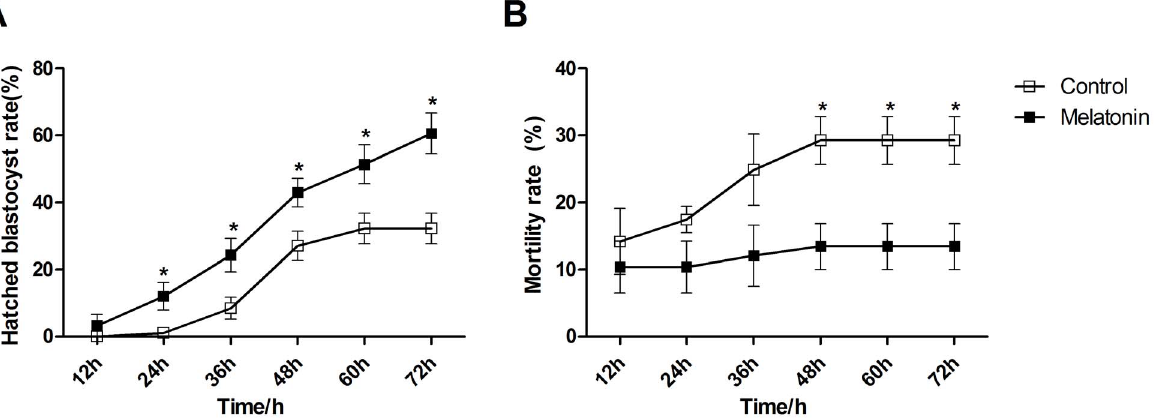
Figure 2. Effects of melatonin on blastocyst re-expansion and survival following vitrification and thawing. A: hatched blastocyst rate at different times after thawing. B: mortality rate at different times after thawing. Different superscripts indicate significant differences (P , 0.05) between treatments at a given time point.